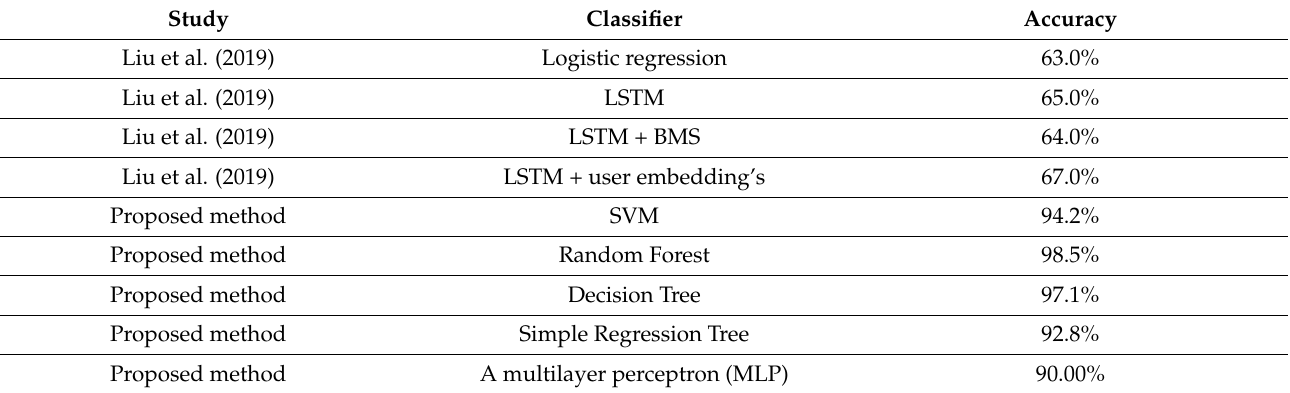
Table 9. The comparison of the proposed method’s results with the related